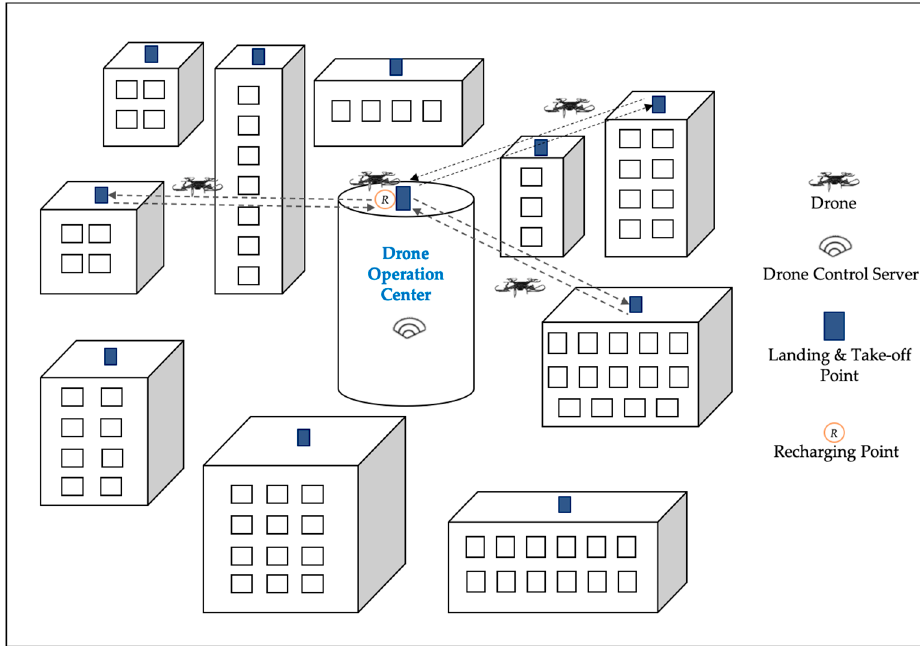
Figure 1. Drone-based parcel delivery using the rooftops of buildings.